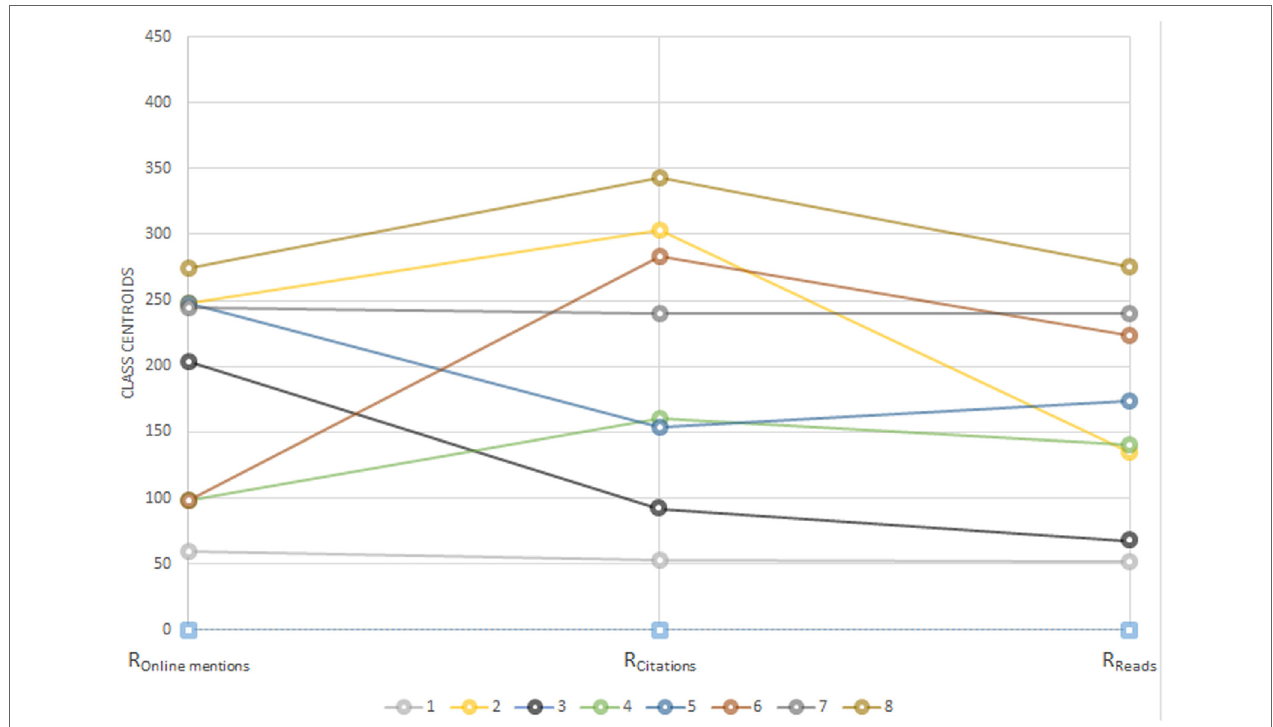
FigUre 6 | Academic performance patterns according to author-level metrics performance.